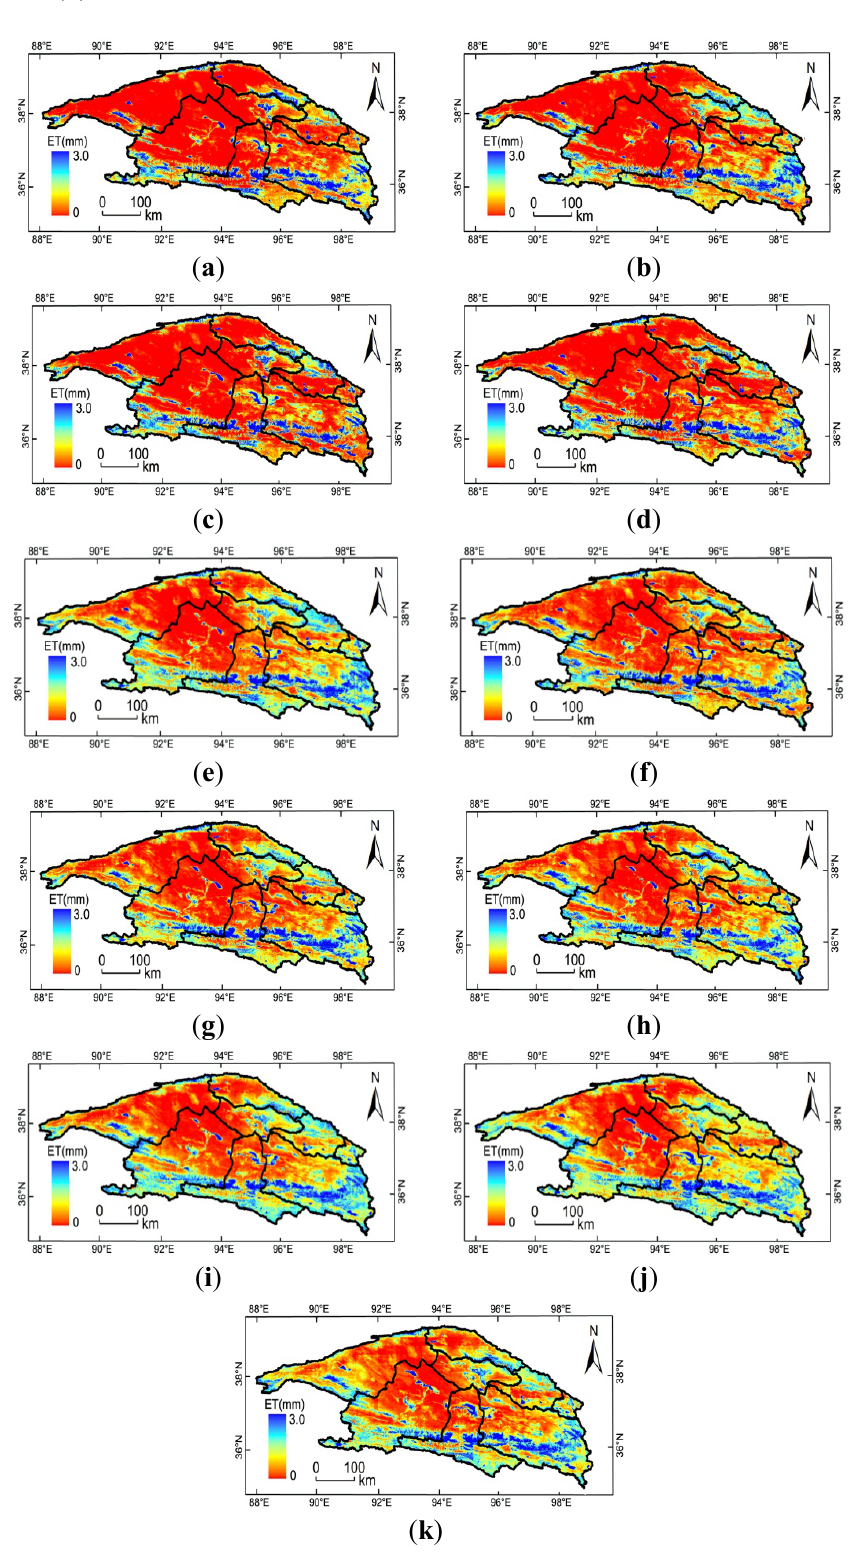
during the period of a